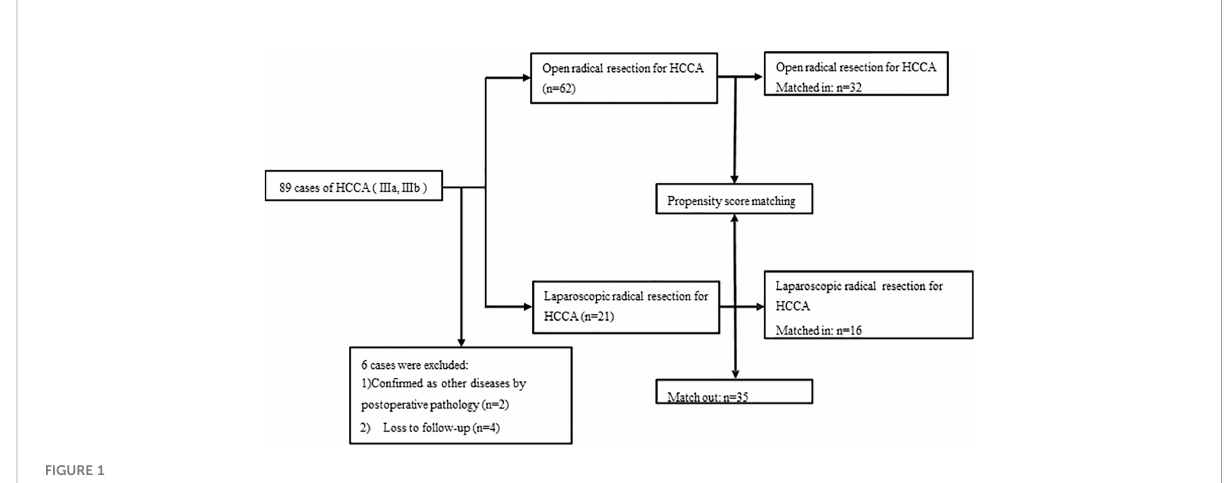
FIGURE 1 Flow chart of patient